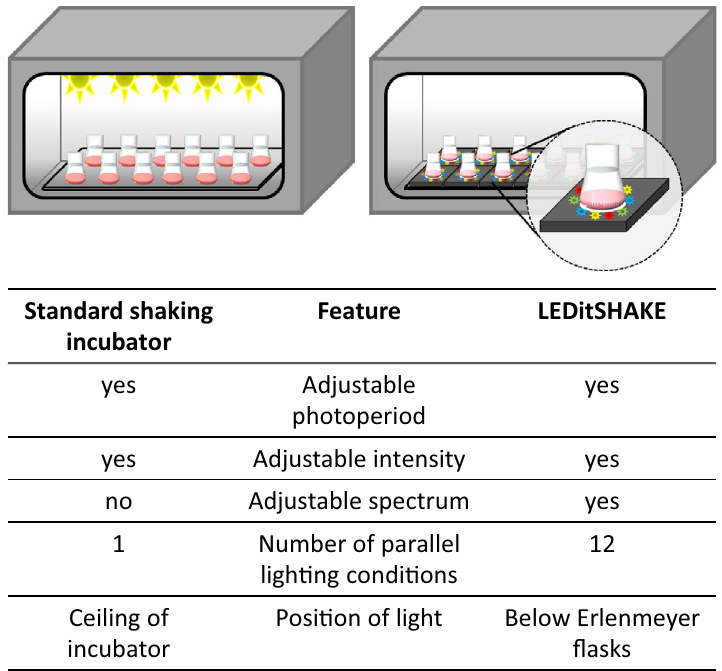
Figure 1. The key features of the LEDitSHAKE (LiS) system compared to a state-of-the-art illuminated shaking incubator. Schematic drawings of both setups are included. LiS is shown with the lightproof cases removed so that the light source can be seen.